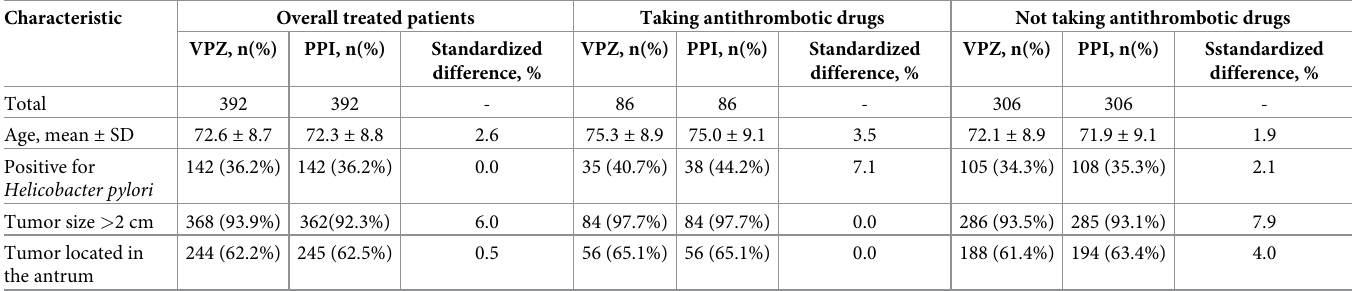
Table 3. Patient characteristics in the observational study after propensity score matching according to antithrombotic drug treatment. Characteristic